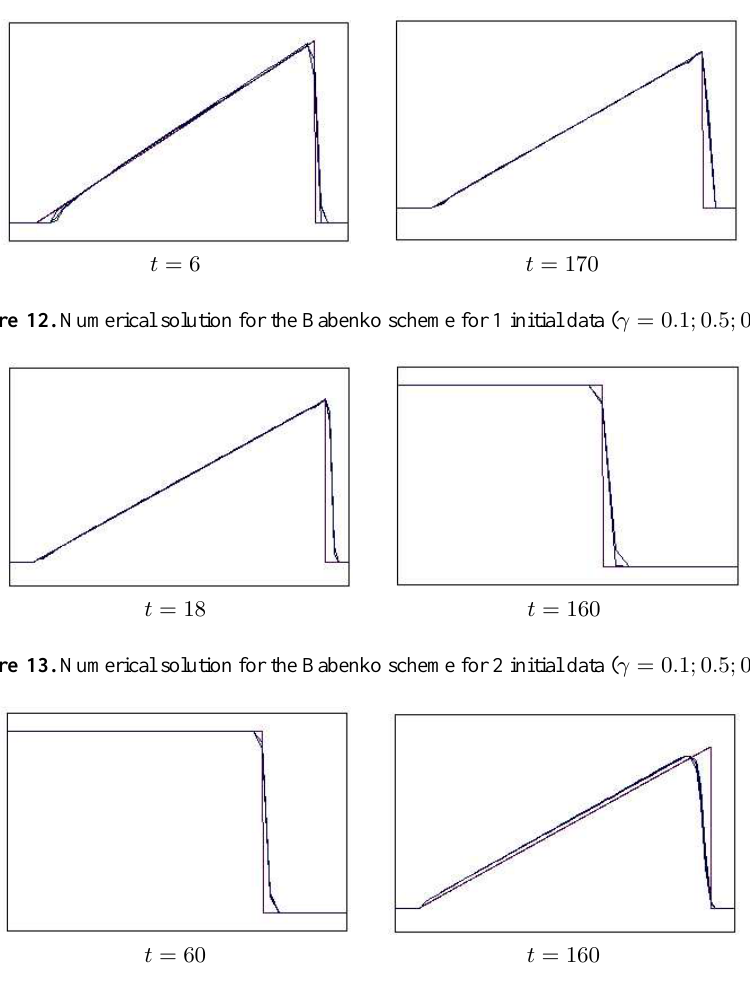
Figure 14. Numerical solution for the Babenko scheme for 3 initial data ( (cid:13) = 0 : 1; 0 : 5; 0 : 9